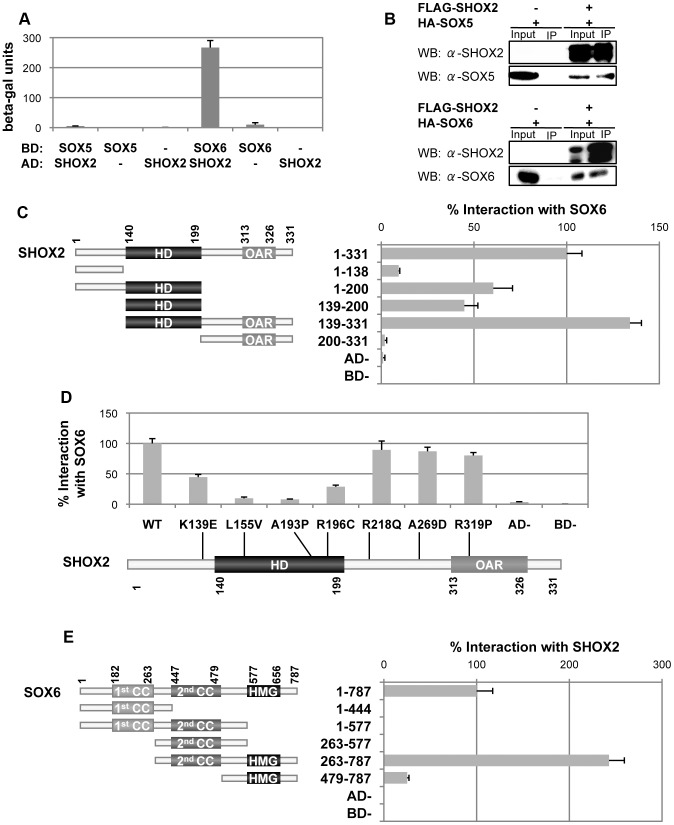
Identification and characterization of the SHOX2-SOX5 and SHOX2-SOX6 protein interactions.A) SHOX2 interacts with SOX5 and SOX6 in the yeast-two hybrid system. The S. cerevisiae strain Y187 was cotransformed with the pGBT9 (BD) and pACT2 (AD) vectors. Interactions were determined by using a β-galactosidase liquid assay with CRPG as substrate. Empty vectors were employed as negative controls. B) SHOX2 interacts with SOX5 and SOX6 in human cells. Nuclear extracts of HEK293 cells overexpressing FLAG:SHOX2 and HA:SOX5 or HA:SOX6 were immunoprecipitated using anti-FLAG-agarose. Western blots (WB) of immunoprecipitates (IP) were probed with SHOX2, SOX5 and SOX6 antibodies. Nuclear extracts corresponding to 10% input were included as protein expression controls and nuclear extract immunoprecipitates of cells transfected only with HA:SOX5 or HA:SOX6 were included as negative controls. The western-blot images clearly show that SOX5 and SOX6 immunoprecipitate only in the presence of SHOX2. C) Characterization of the SHOX2 domains involved in the interaction with SOX6. An scheme of the SHOX2 protein structure showing the amino acid location of the homeodomain (HD) and the OAR domain is shown with the various analysed SHOX2 fragments, indicating their name and the amino acids that they contain. To the right of each fragment, the corresponding yeast two-hybrid results are shown. Y187 cells were cotransformed with SOX6 in the pGBT9 vector and the SHOX2 fragments in the pACT2 vector. Protein interaction percentages were obtained by normalizing the β-galactosidase units of the different SHOX2 fragments to that obtained with full-length SHOX2. Empty vectors were employed as negative controls. D) SHOX2 mutants impair the interaction with SOX6. SHOX2 protein structure scheme showing the localization of the seven missense mutations analyzed. Yeast two-hybrid assay of Y187 cotransformed cells with SOX6 in the pGBT9 vector and the different SHOX2 mutants in the pACT2 vector. Protein interaction percentages were obtained by normalizing the β-galactosidase units of the various SHOX2 mutants to the wildtype SHOX2. Empty vectors were employed as negative controls. E) Characterization of SOX6 domains involved in the interaction with SHOX2 using the yeast two-hybrid assay. SOX6 is schematically drawn showing the amino acid location of two dimerization domains, the first and the second coiled-coils (1st cc and 2nd cc, respectively), and the HMG DNA-binding domain. Depicted below are the SOX6 generated constructs, indicating the name of each fragment and the amino acids that they contain. Y187 cotransformed cells with the different SOX6 fragments in the pGBT9 vector and SHOX2 in the pACT2 vector. The protein interaction percentages were obtained by normalizing the β-galactosidase units of the different SOX6 fragments to that obtained with full-length SOX6. Empty vectors were employed as negative controls.